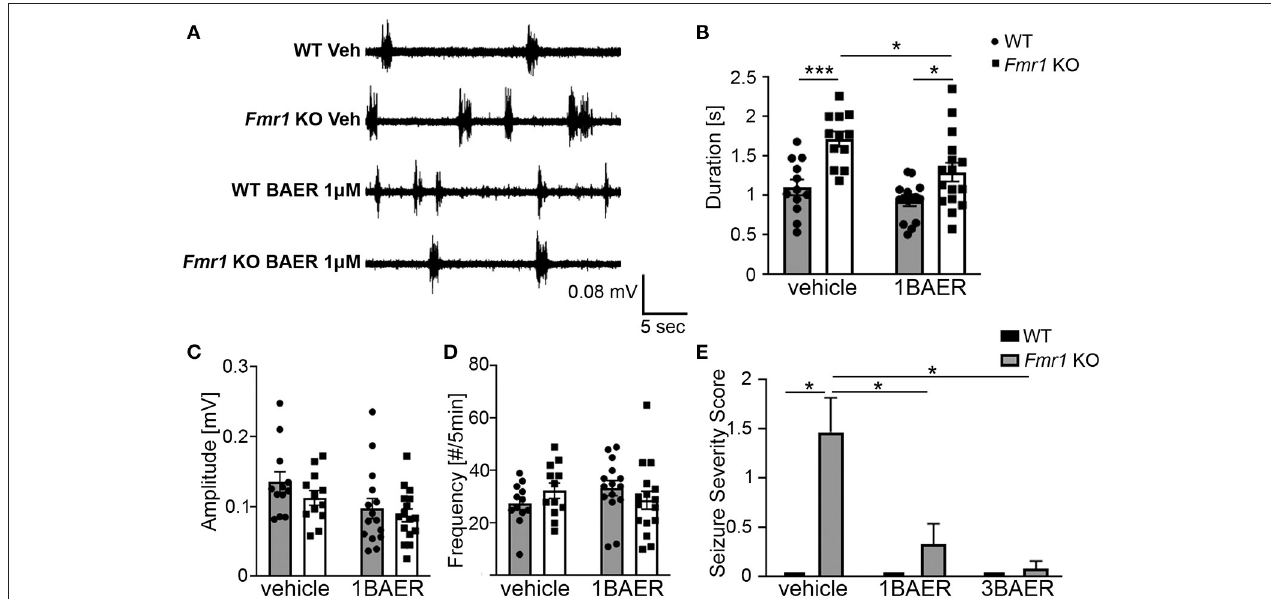
FIGURE 1 | BAER-101 reduces neocortical hyperexcitability and seizures in Fmr1 KO mice. (A – D) Increased duration of spontaneous UP states in neocortical slices from Fmr1 KO mice is reduced to WT levels by bath application of 1 µ M BAER-101. (A) Representative extracellular multi-unit recordings from layer IV of acute neocortical slices prepared from WT or Fmr1 KO mice and preincubated for 1–1.5h in either BAER-101 (1 µ M) or vehicle (0.03% DMSO). (B) Increased duration of UP states in Fmr1 KO slices is reduced by BAER-101 [2-way ANOVA with Sidak’s multiple comparison, p (genotype) < 0.0001, p (drug) = 0.004, p (interaction) = 0.22]; *** p < 0.001; * p < 0.05. (C) Amplitude of UP states was reduced by BEAR-101 but not affected by genotype and no interaction was detected [2-way ANOVA, p (genotype) = 0.2, * p (drug) = 0.015, p (interaction) = 0.61]. (D) UP state frequency was not affected by genotype or treatment [2-way ANOVA, p (genotype) =